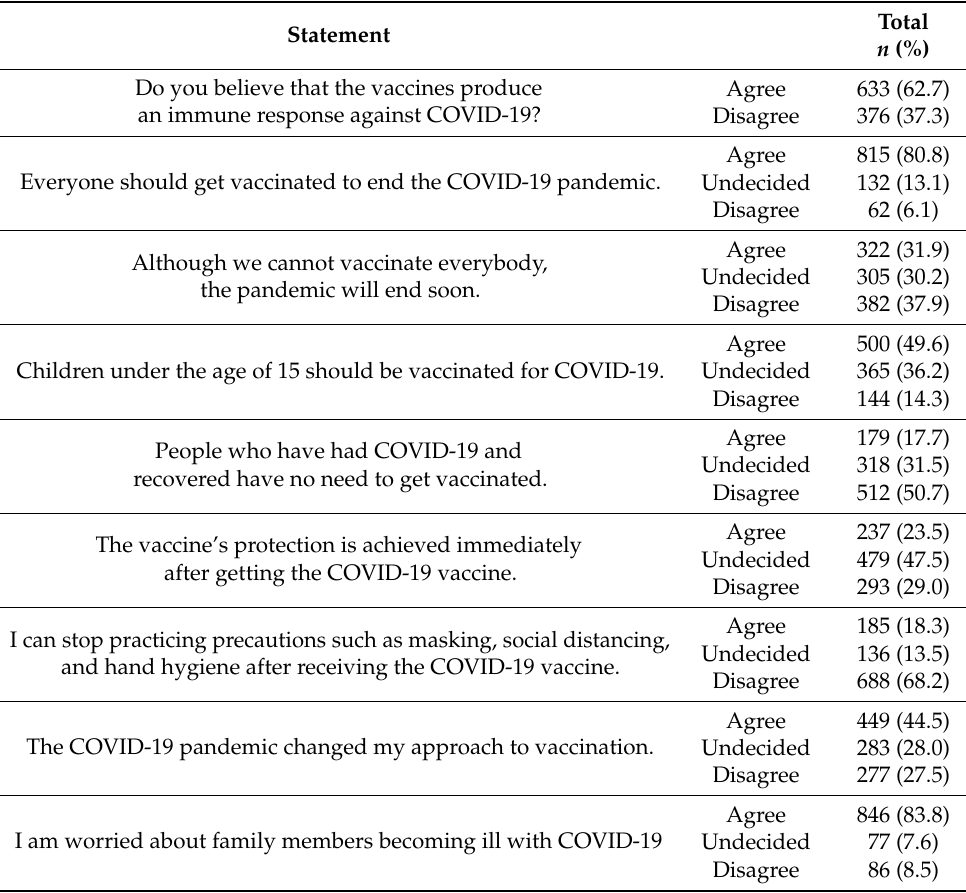
Table 1. Knowledge and practice of study participants toward COVID-19 vaccine in